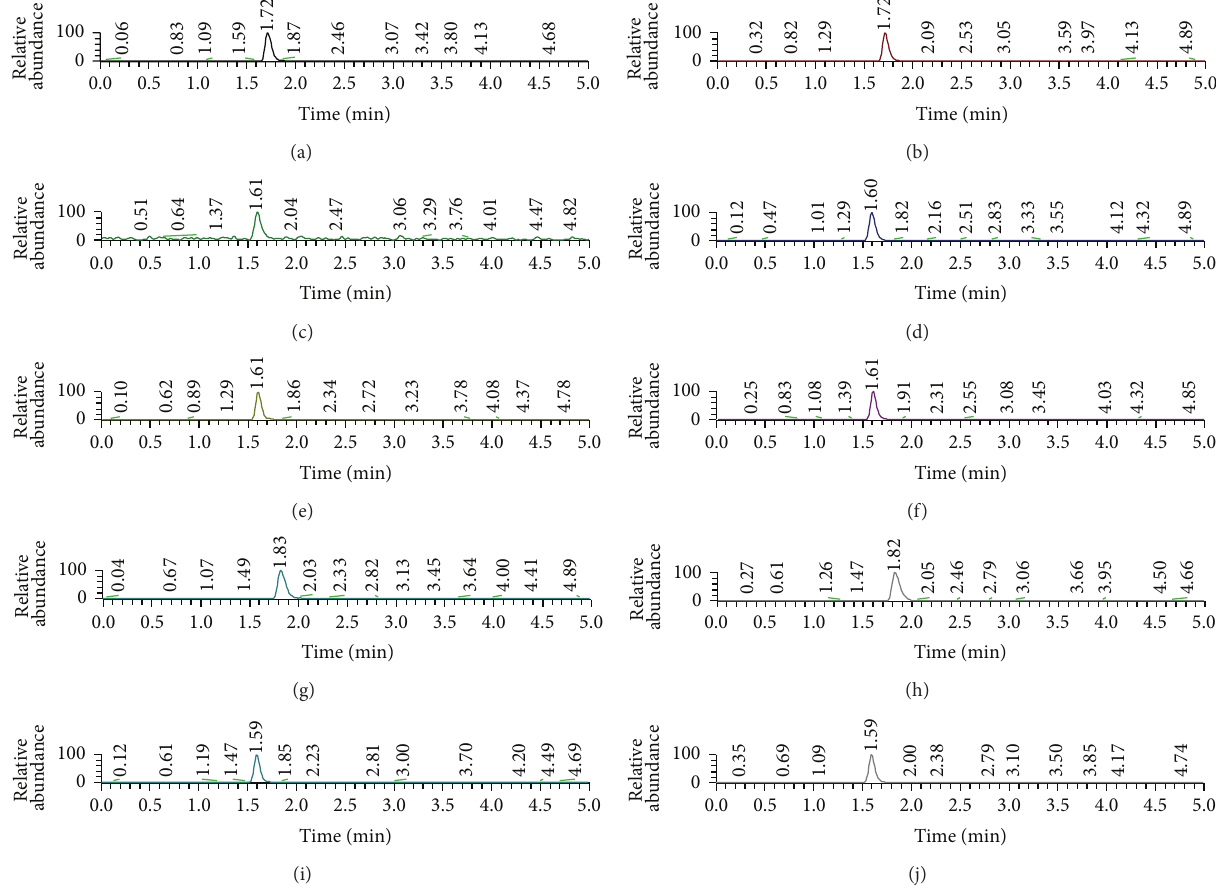
Q3 mass spectra and proposed fragmentation patterns were BH4, which becomes at 2-amino-7,8-dihydropteridin-4(1H)- one of m/z 166.0 by losing propane-1,2-diol. DA becomes butane-1,2-diol of m/z 90.9 by losing (E)-3-methylpent- 3-en-1-amine; IS, (E)- N -ethylidenepentan-1-amine of m/z